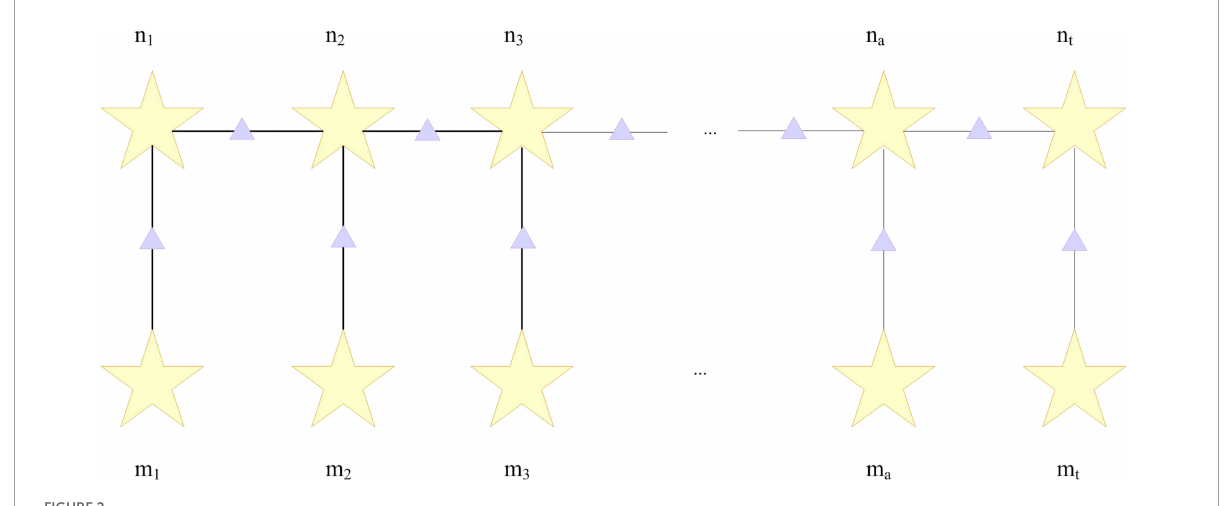
FIGURE2 Linear chain conditional random field factor